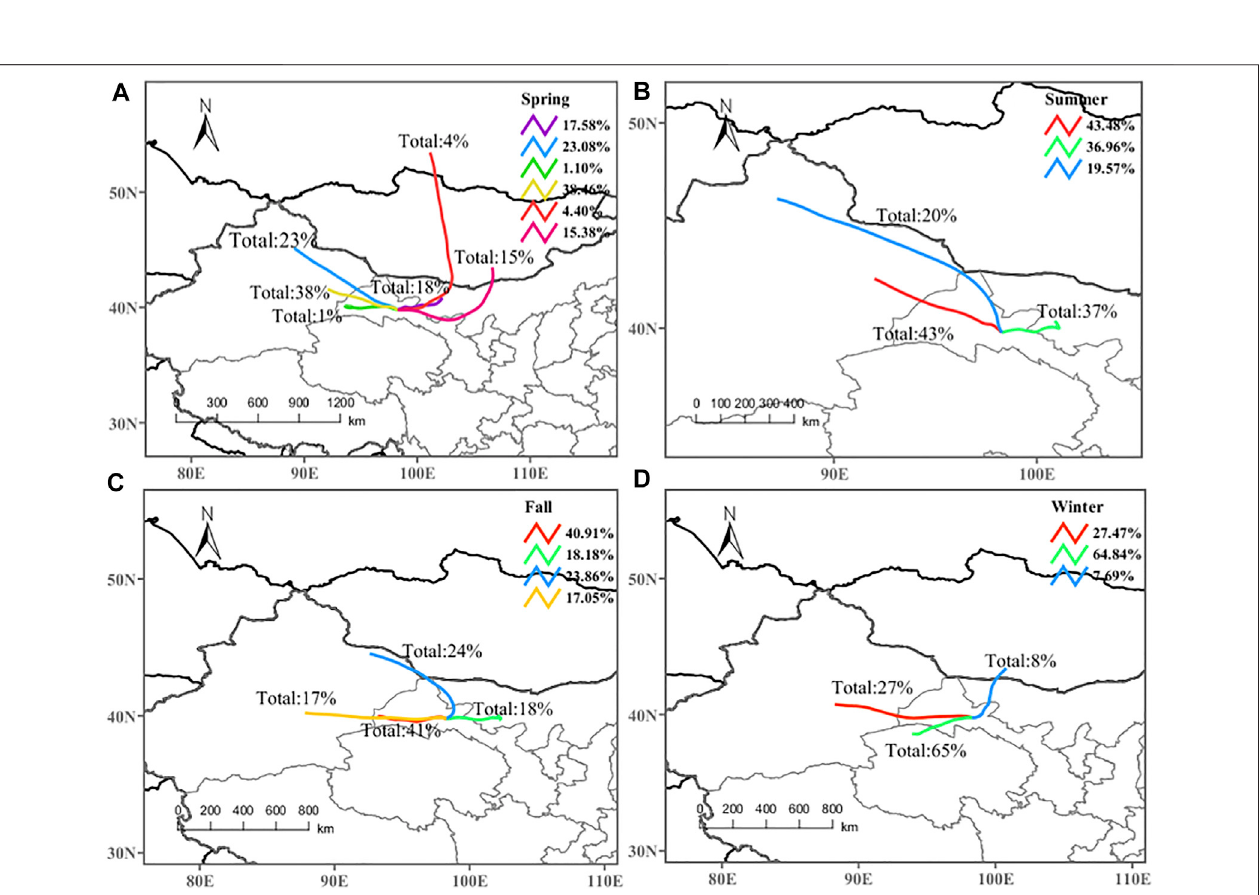
FIGURE 4 | Analytical results of 48 h air mass back trajectories arriving at 500 m elevation in four seasons in Jiuquan city. The percentage in the fi gure represents the proportion of the air mass to the total backward trajectory.